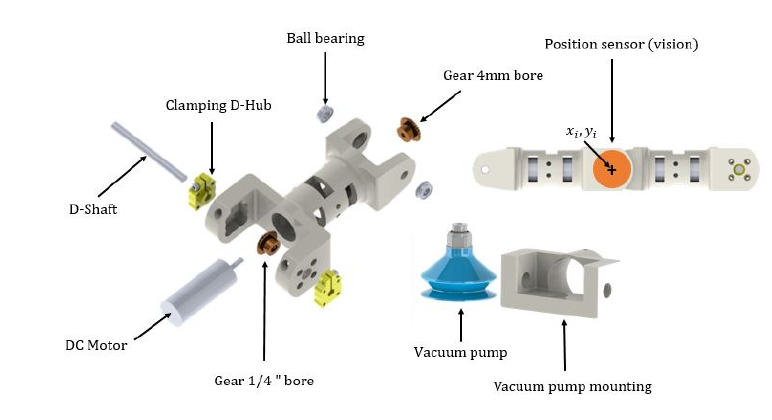
Figure 2. Elements of each link in the WBRD.